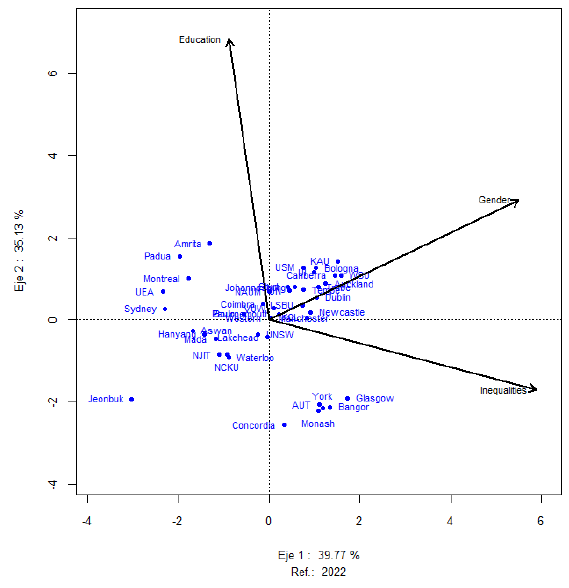
Figure 1. Factor representation HJ biplot for The Impact Rankings (2022), plane 1–2.